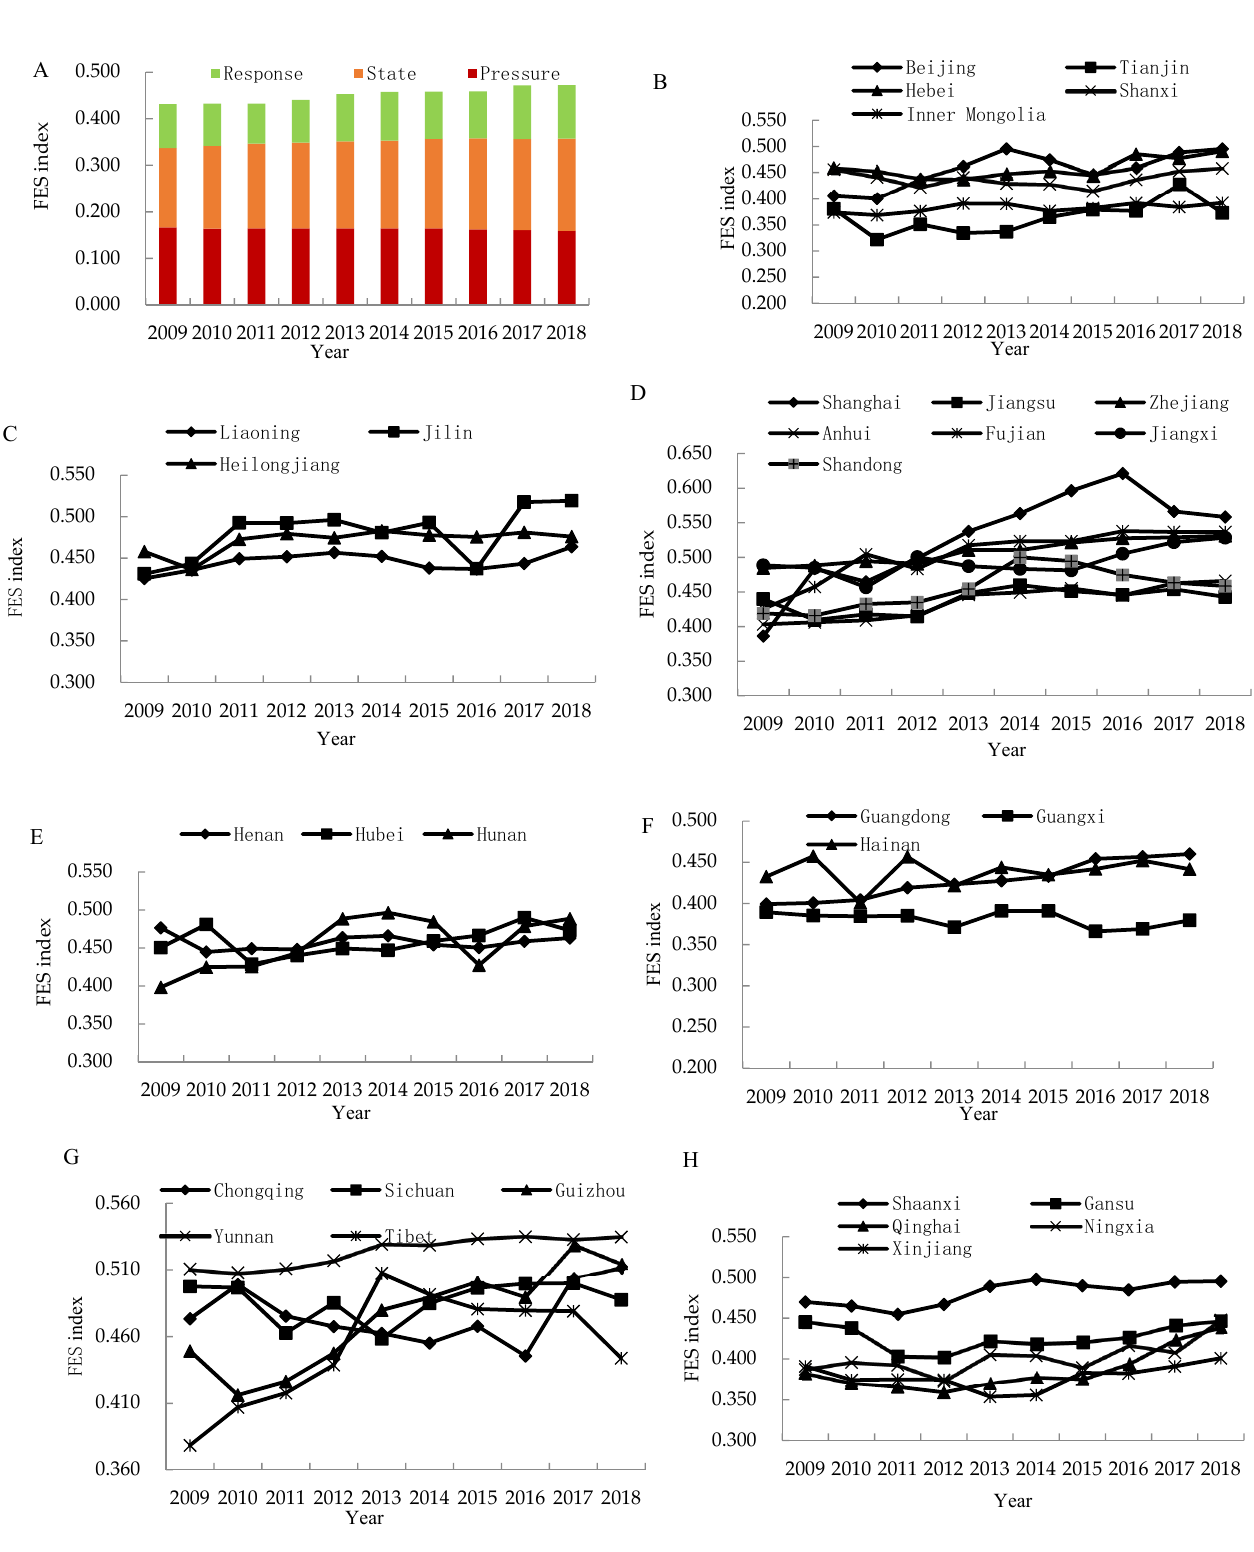
Figure 1. The changes of FES index in China and various regions. ( A ) The changes of FES index in China; ( B ) the changes of FES index in the north area; ( C ) the changes of FES index in the northeast area; ( D ) the changes of FES index in the east area; ( E ) the changes of FES index in the central area; ( F ) the changes of FES index in the south area; ( G ) the changes of FES index in the southwest area; ( H ) the changes of FES index in the northwest area.